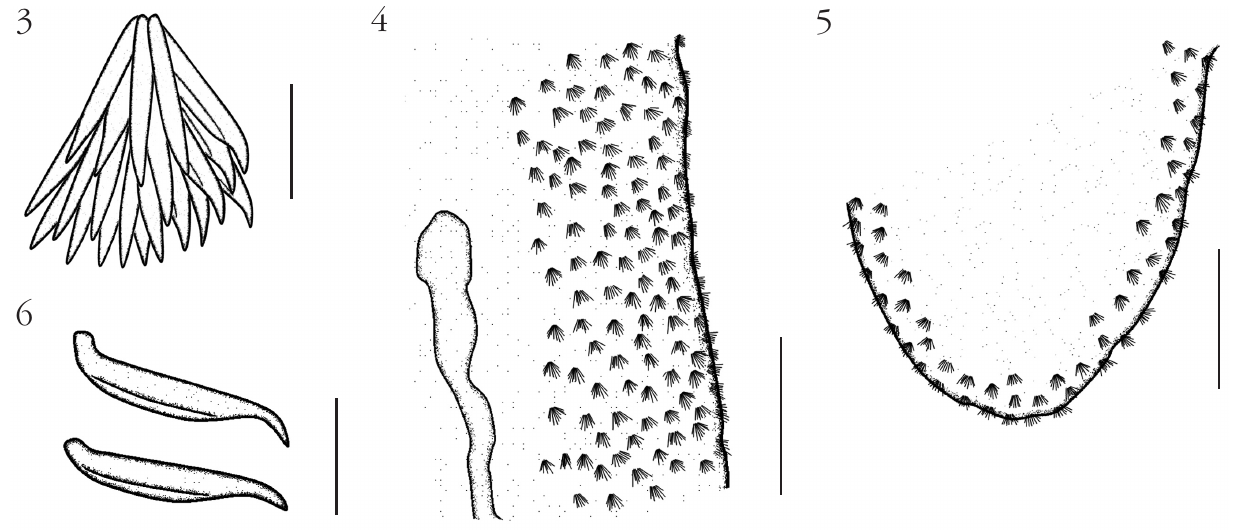
Figs 3-6. – Aporocotyle mariachristinae n. sp. from Genypterus blacodes : 3, cluster of spines; 4, distribution of clusters of spines along ventro-lateral body margins near the anterior left caecum, ventral view; 5, distribution of clusters of spines at ventral posterior body end; 6, tegumental spines. Scale bars: Figs 3 and 4: 100 μ m; Figs 5 and 6: 10 μ